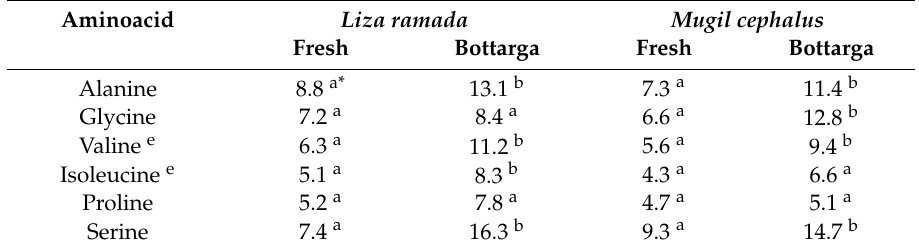
Table 4. Free amino acid composition (% ± RSD) of fresh roe and bottarga from L. ramada and M. cephalus